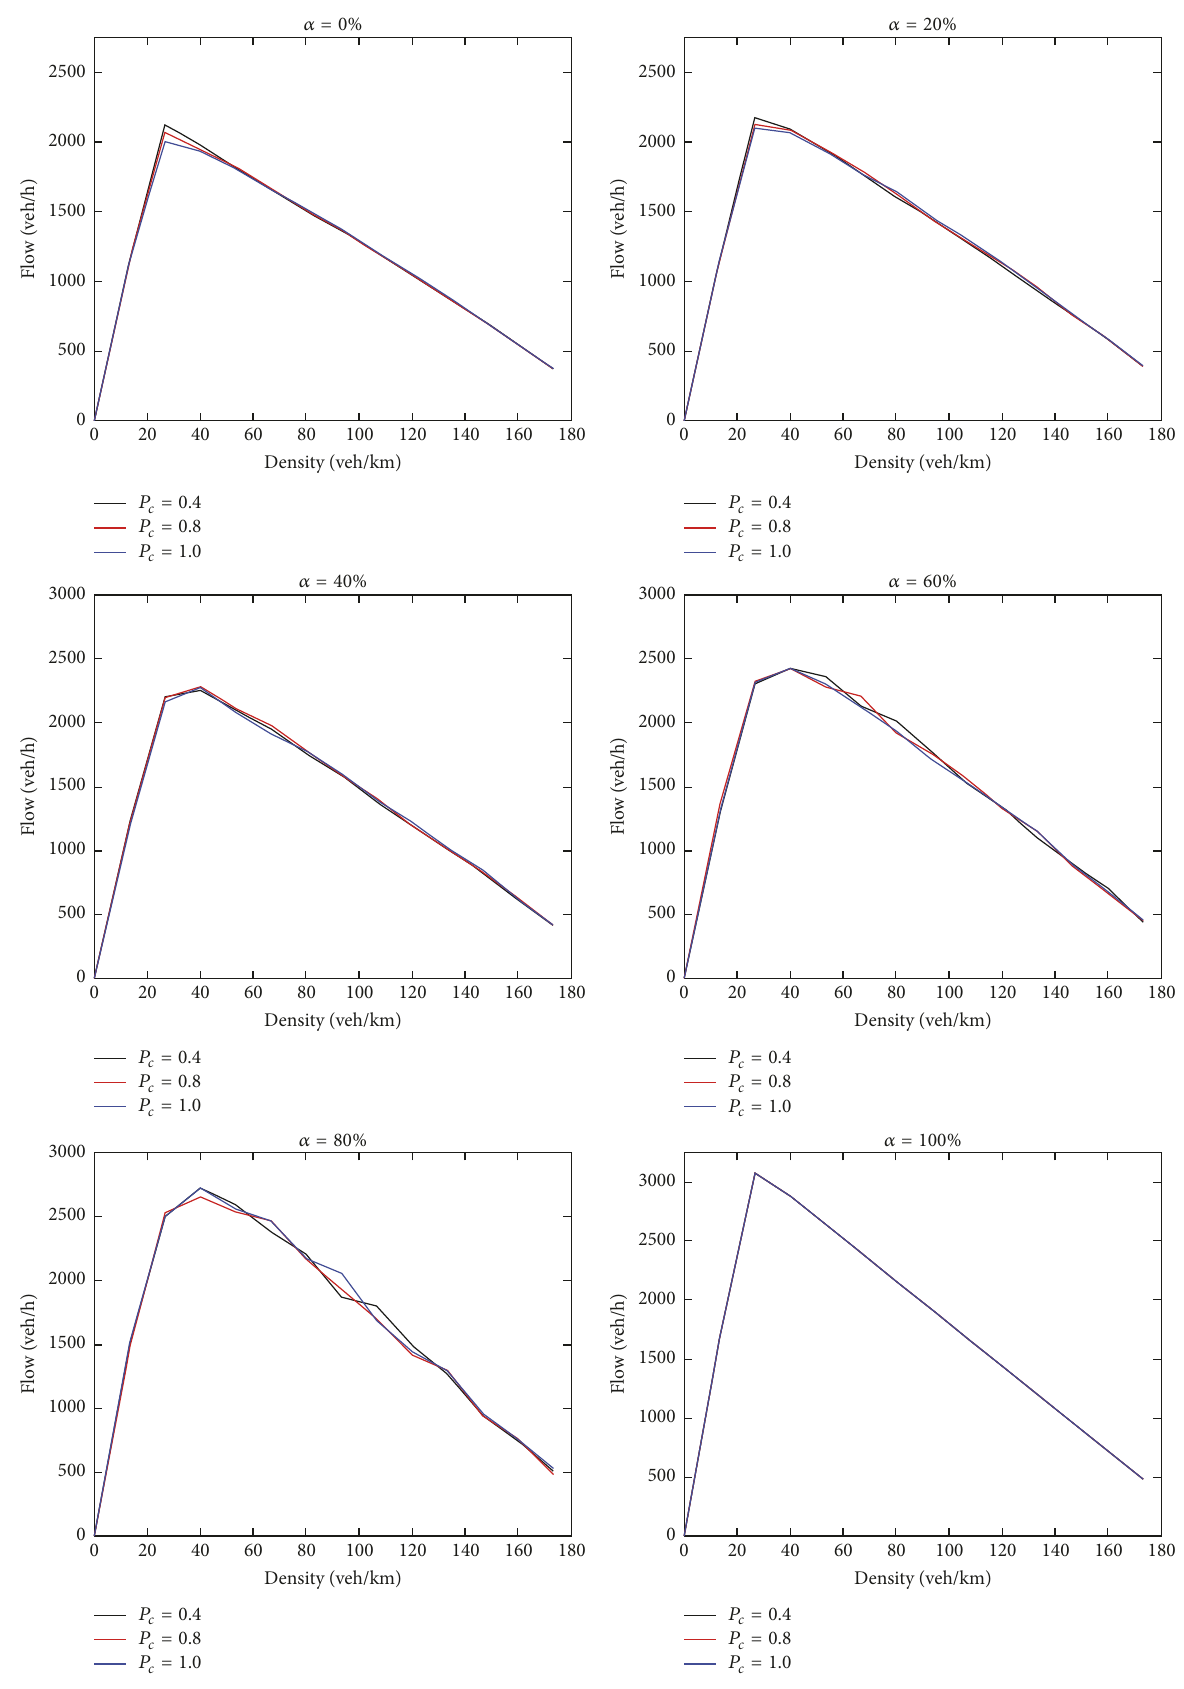
Figure 4: Fundamental diagrams for different lane-changing probabilities ( 𝑃 𝑐